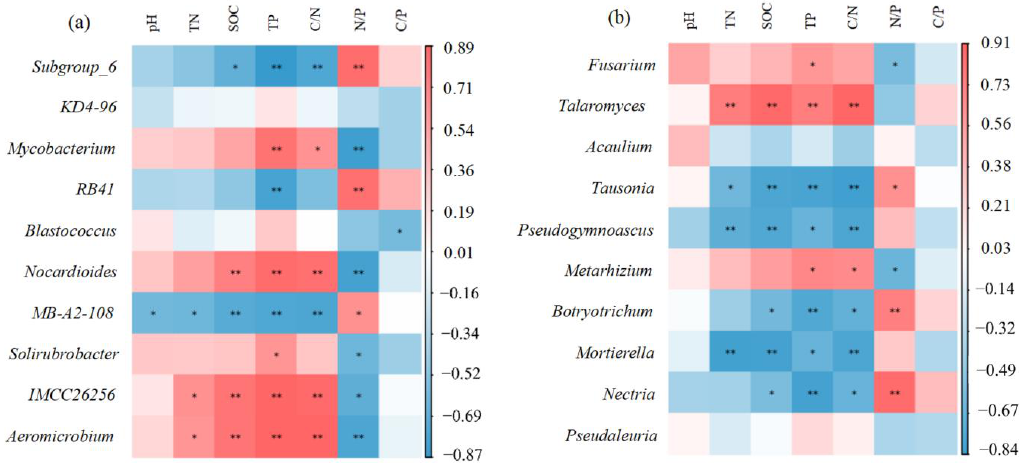
Figure 4. Pearson correlation analysis between soil physicochemical properties and the top ten bacterial genera in soil bacterial and fungal communities. Colors indicate relevance. The color corresponds to the ruler value on the right side of the image. Red means positive correlation, and blue means negative correlation. ** and * significant at 1% and 5% probability, respectively. ( a ) Correlation between bacterial genera and soil properties. ( b ): Correlation between fungal genera and soil properties.